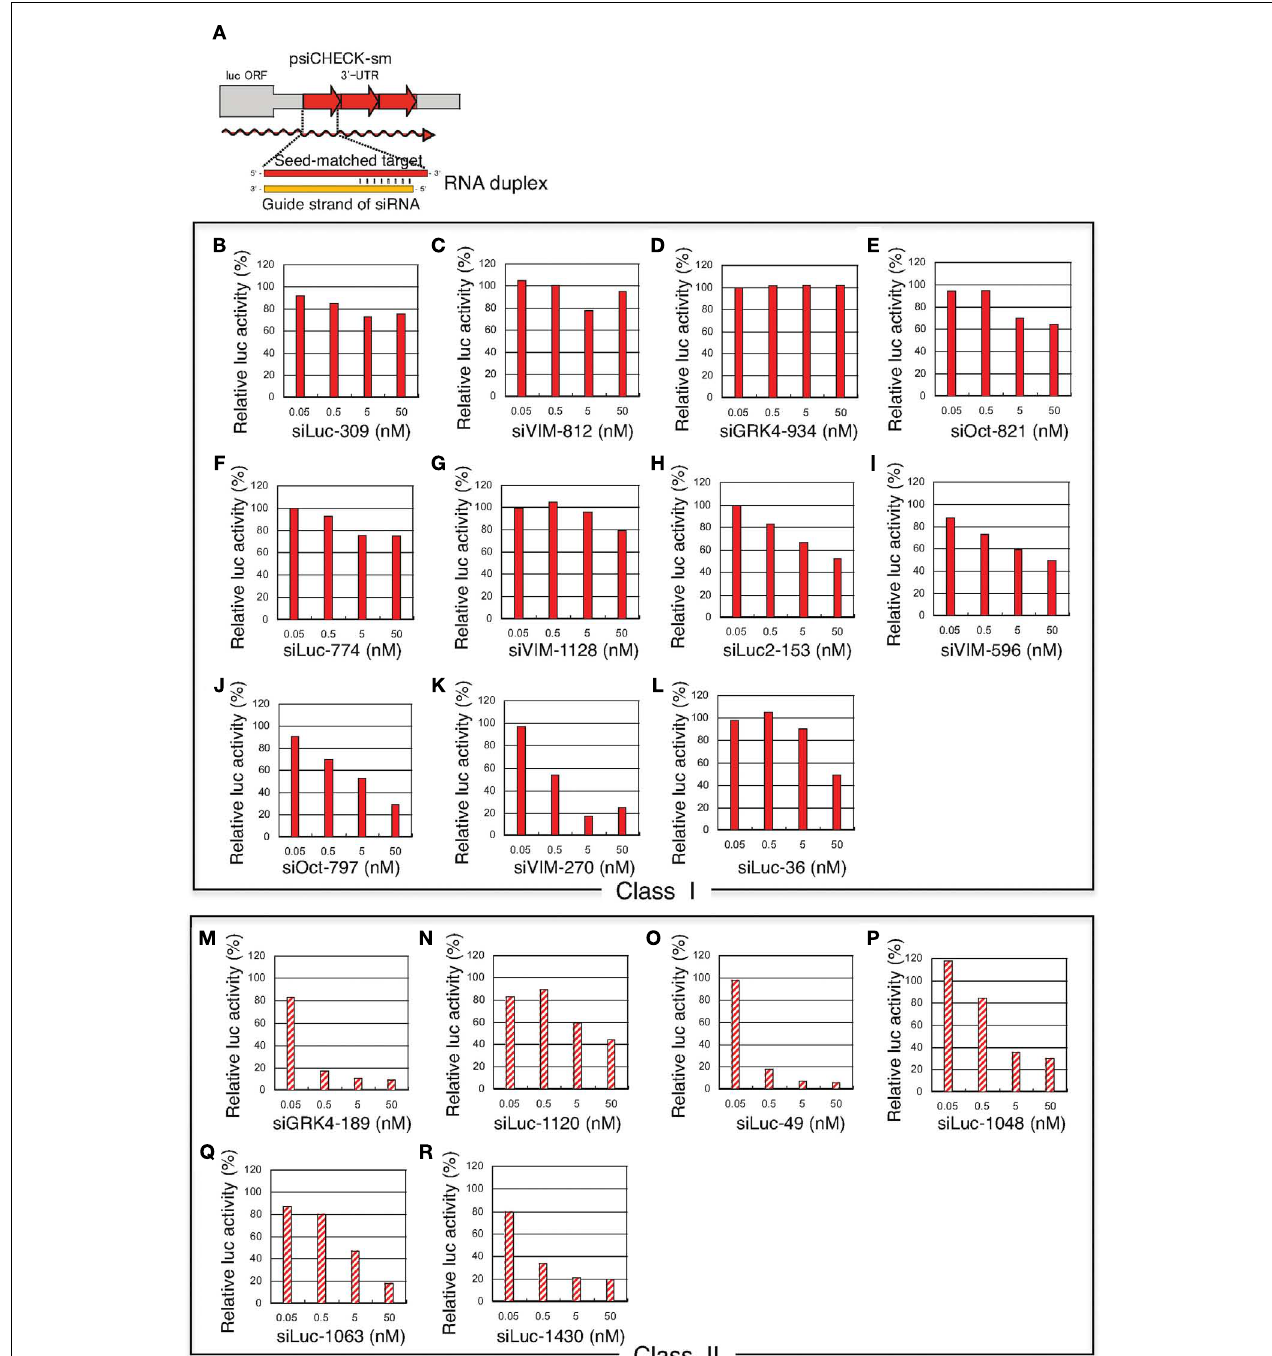
seed-matched target sequences were introduced into the region corresponding to the 3 (cid:2) UTR of the luciferase mRNA. In (B–R) , the effects of non-modified siRNA transfection on seed-matched targets are shown. (B–L) class I siRNAs, (M–R) class II siRNAs, (B) siLuc-309, (C) VIM-812, (D) GRK4-934, (E) Oct-821, (F) Luc-774, (G) VIM-1128, (H) Luc2-153, (I) VIM-596, (J) Oct-797, (K) VIM-270, (L) Luc-36, (M) GRK4-189, (N) Luc-1120, (O) Luc-49, (P) Luc-1048, (Q) Luc-1063, (R) Luc-1430. siRNA sequences and structures are shown in Figure 3A